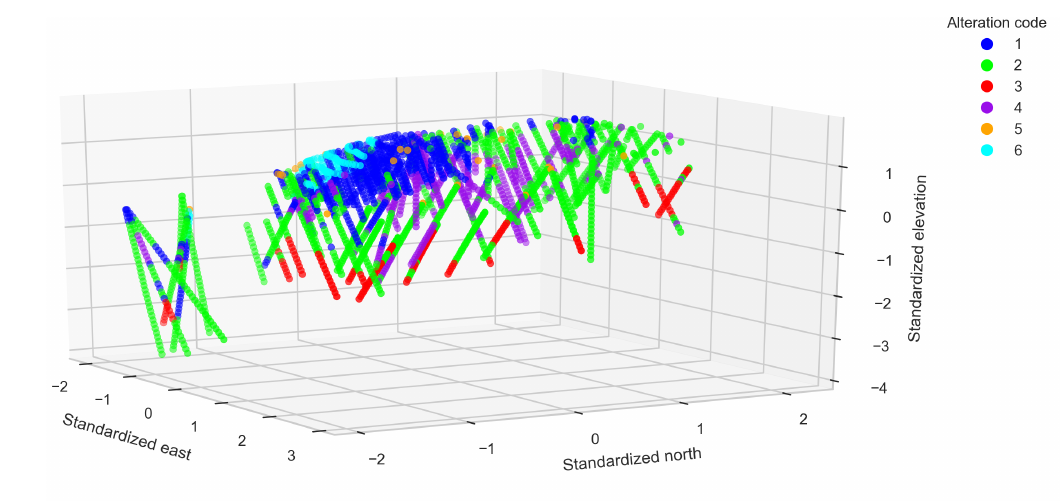
Figure 5. Isometric view of drill holes by type of